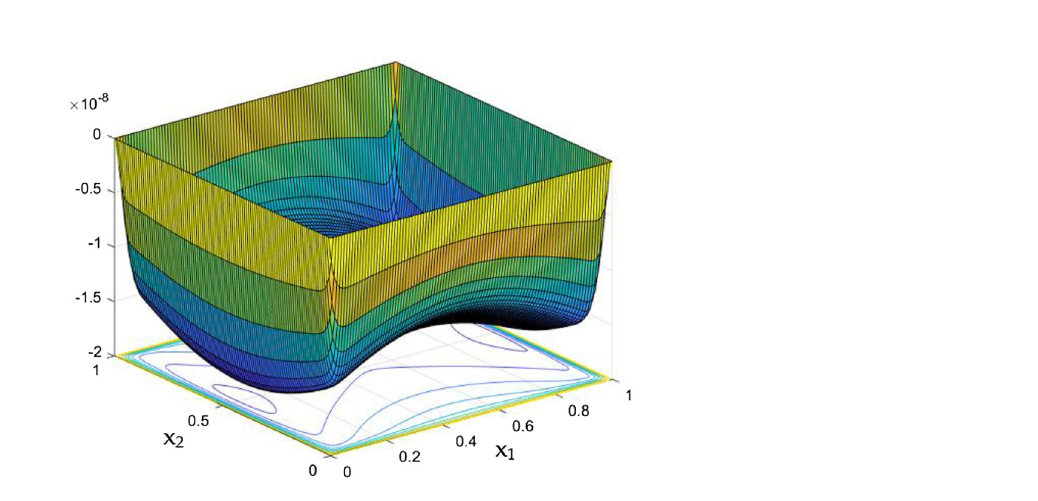
Figure 24. Temperature field for Ra = 100,000 and M =